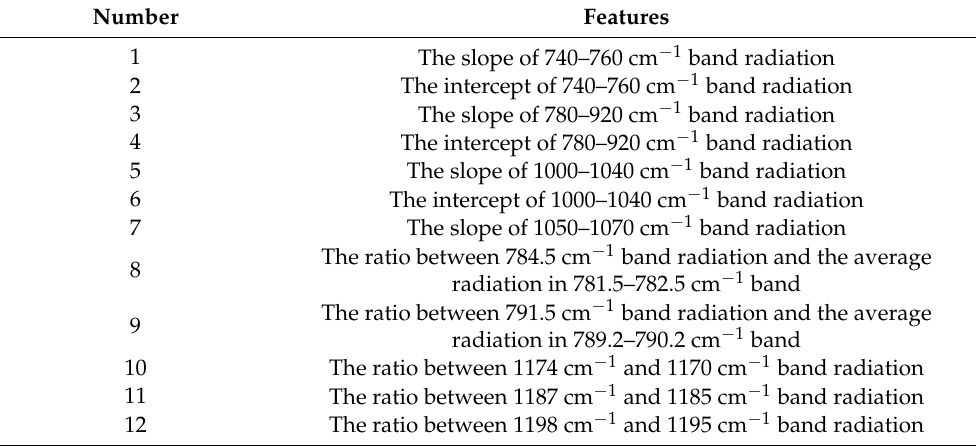
Table 3. Twelve selected features for distinguishing cloudy or cloud-free data. Features 1, 2, and 5–12 correspond to the black background parts of Figure 2a, while features 3 and feature 4 correspond to the purple background